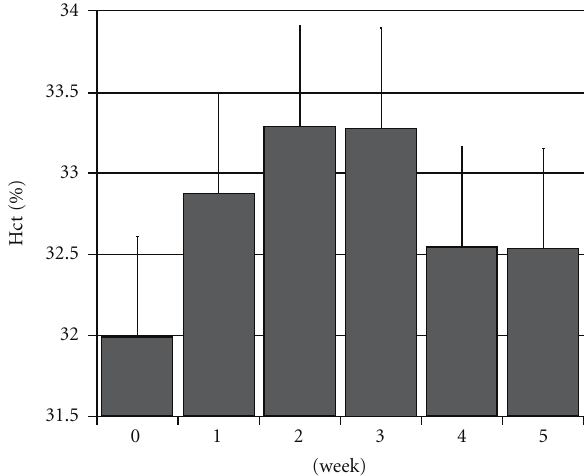
Figure 1: The changes of hematocrit during the first 5 weeks after CERA use. The changes of hematocrit in 61 hemodialysis patients during the first 5 weeks. (The mean value and standard deviation of Hct of HD patients are displayed